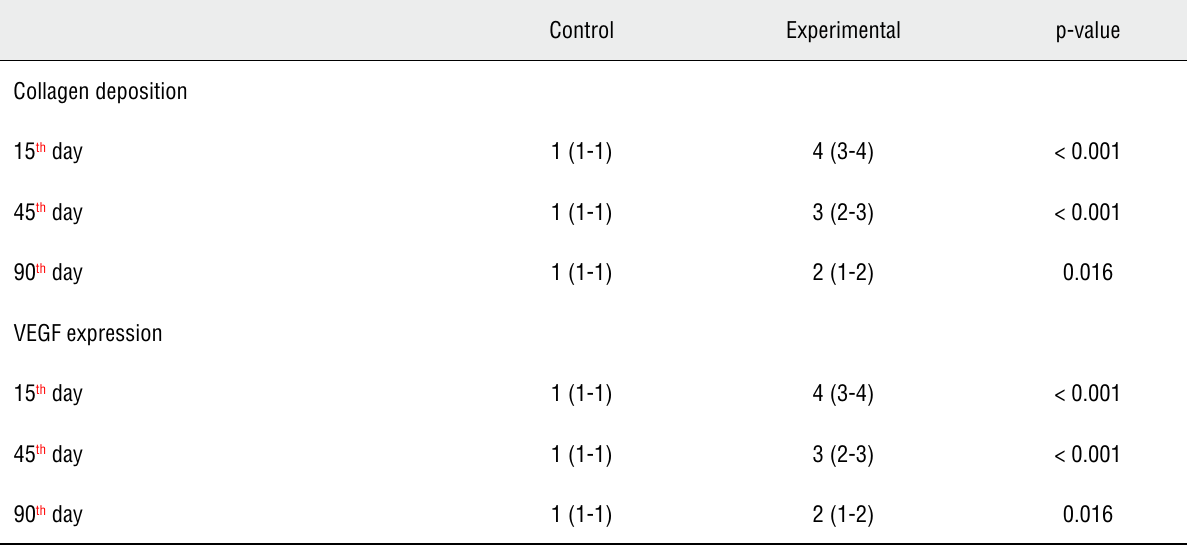
Table 2 - Scores of expression of collagen and vEGF in the groups (experimental and control) at different times of evaluation. Data are expressed as median and